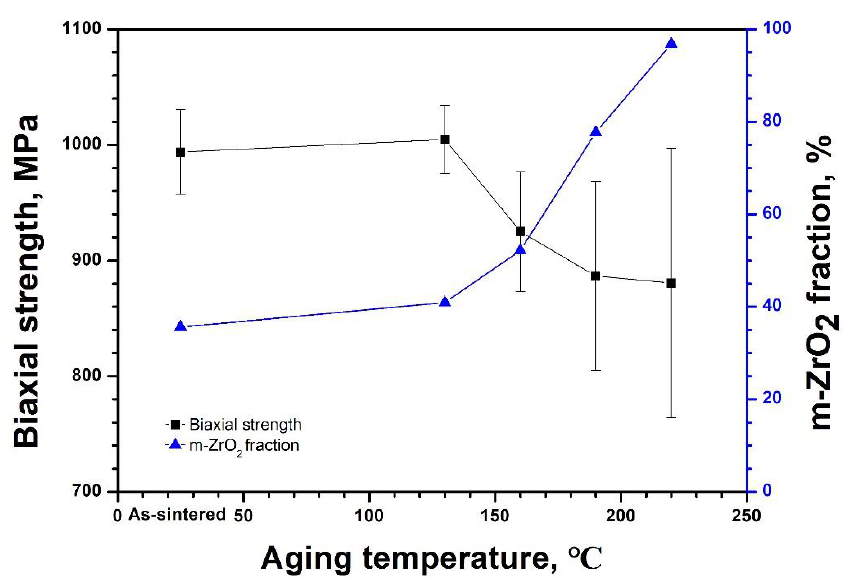
Figure 7. Biaxial strength and fraction of m-ZrO 2 transformed from t-ZrO 2 determined after aging for 10 h at temperatures ranging from 130 °C to 220 °C. The results demonstrate the degradation of strength with